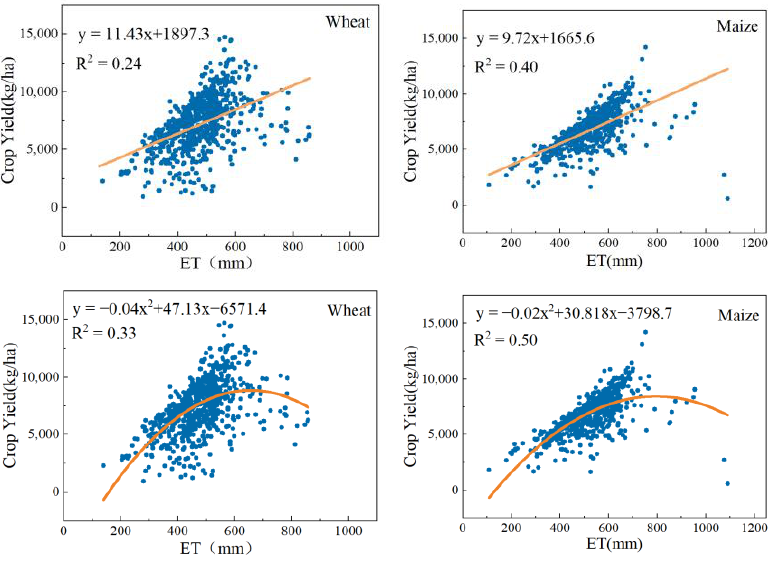
Figure 18. Relationship between crop yield and ET season .